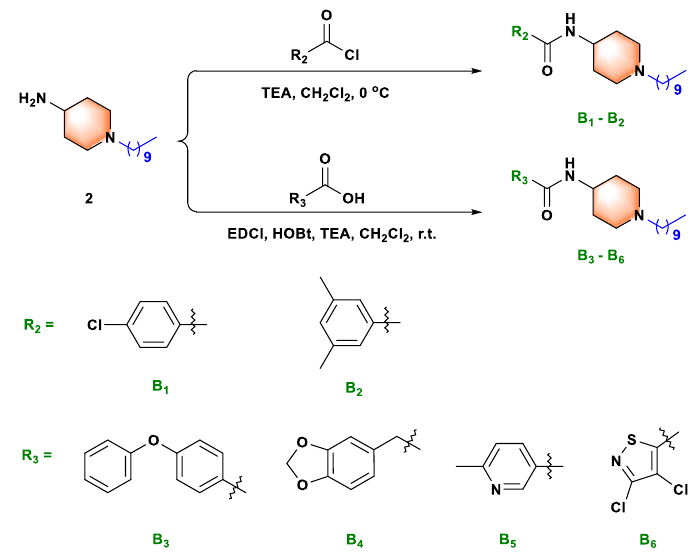
Scheme 2. Synthesis route of title molecules B 1 − B 6 . Table 2. In vitro antibacterial activities of target compounds B 1 − B 6 against plant pathogens. Table 2. In vitro antibacterial activities of target compounds B